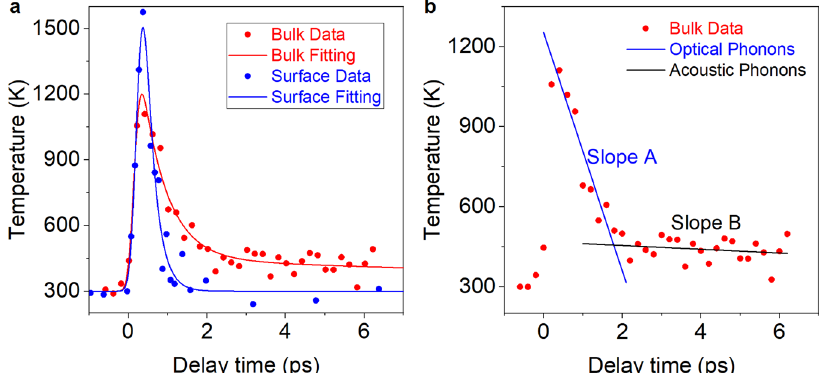
Fig. 4 Theoretical modeling of experimentally obtained data. a Comparison between the transient electronic temperature of the nodal-line bulk and the surface states. The measured temperature data are shown as dots, with the convolution fi tting shown as lines. The decay time of the nodal-line bulk state is found to be longer than the surface state. b The measured bulk temperatures are shown as red dots. The blue and black lines, which are obtained from our theory, represent the optical and acoustic phonons,